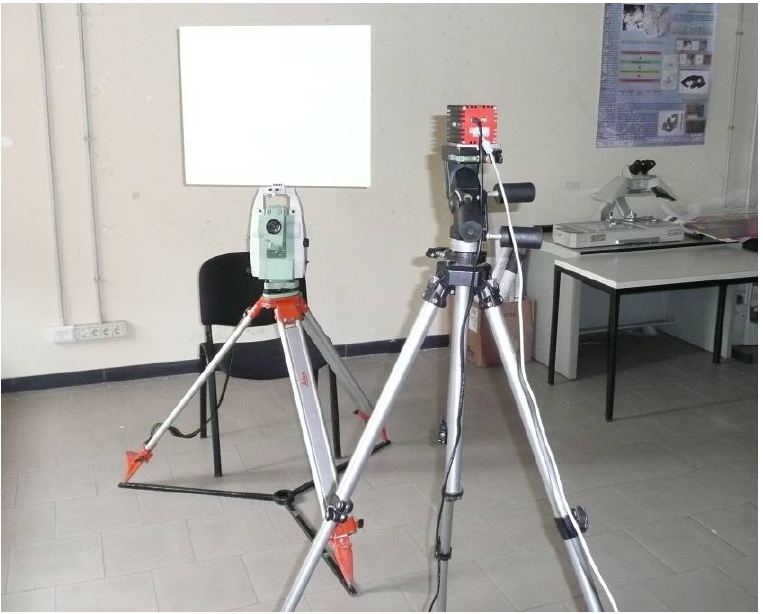
Figure 8. System used to evaluate the influence of the alpha angle on camera distance